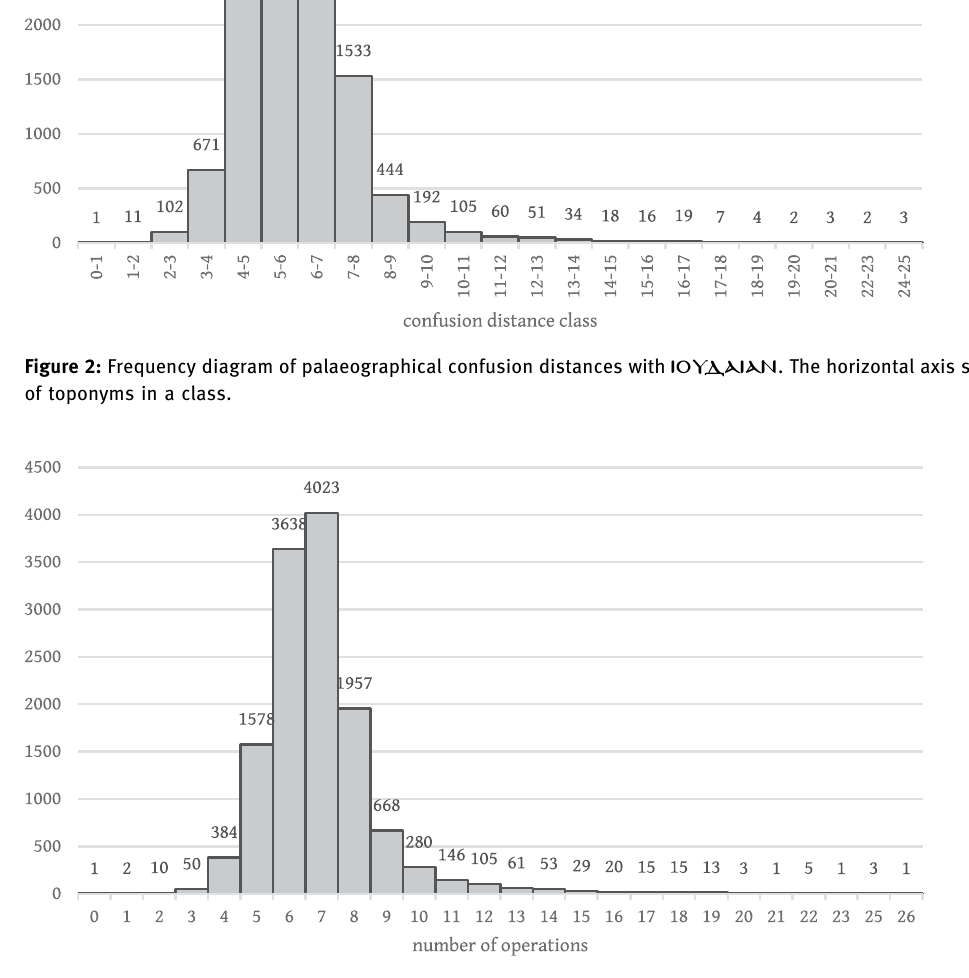
Figure 3: Histogram representing the number of toponyms with a particular number of operations to change the toponym in IO ϒΔ AIAN